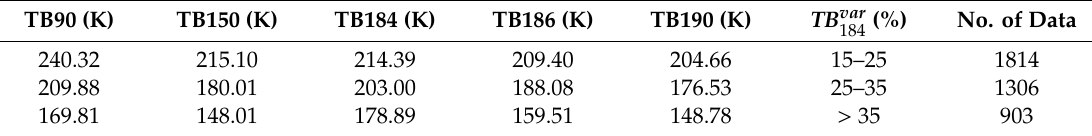
for the training period 2000–2009. 184